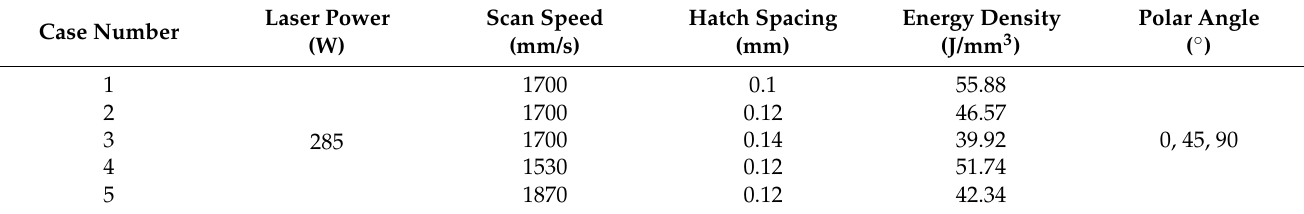
Table 2. SLM process conditions to manufacture thermal conductivity specimens for each test